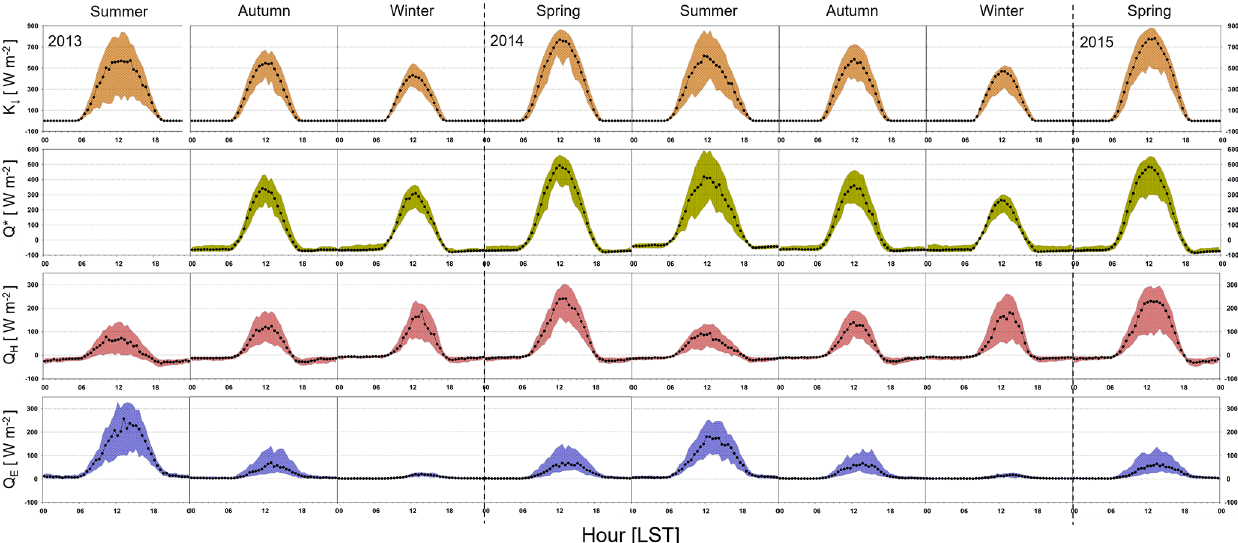
Figure 4. Diurnal variations of surface energy fluxes. Seasonal median diurnal variations (points) and interquartile ranges (shaded) of 30min downward shortwave radiation ( K ↓ ), net radiation ( Q ∗ ), sensible heat flux ( Q H ), and latent heat flux ( Q E ) for 2 years. Since the net radiation system was installed in September 2013, there was no Q ∗ value in the first summer.